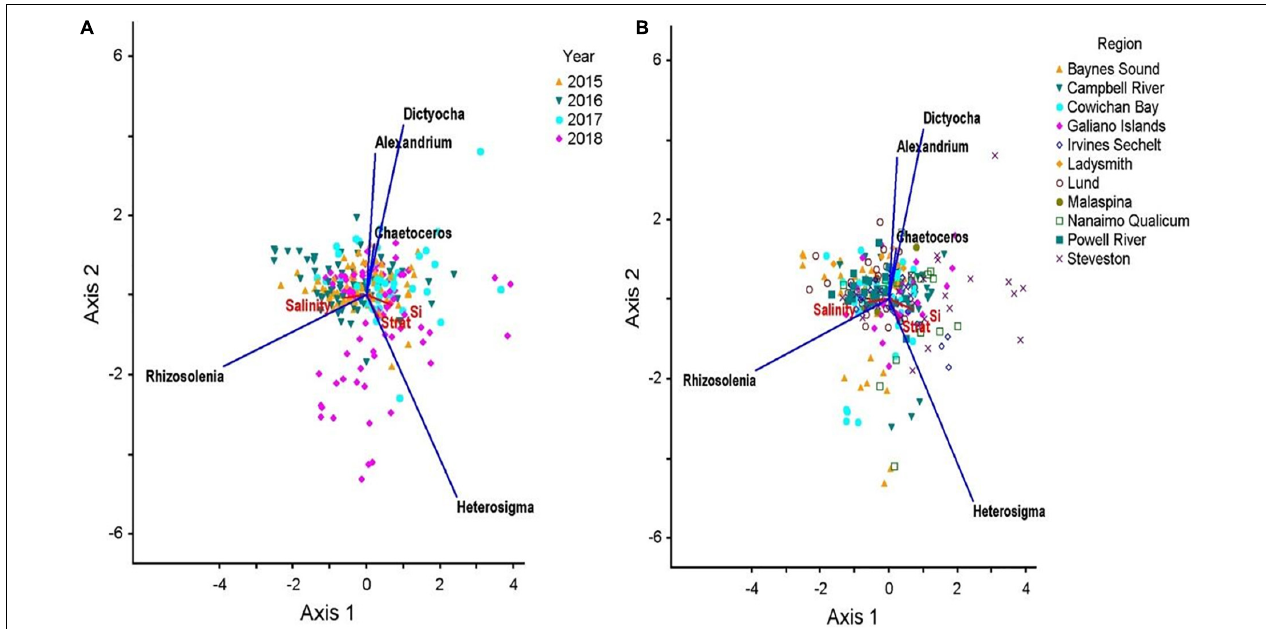
FIGURE 8 | RDA triplots showing the relationships between HABs taxa and physico-chemical parameters averaged across all summers from 2015 to 2017 in the Strait of Georgia grouped by station (A) and year (B) . RDA plots display 9% (RDA axis 1) and 3% (RDA axis 2) of HABs abundance variance. Eigenvalues are 0.045 and 0.016 for the first and second axes, respectively. Vectors show the relationships between physico-chemical variables and the two ordination axes. Vectors pointing in the same direction indicate variables that are highly correlated, whereas vectors pointing in opposing directions indicate the variables are negatively correlated. (Note: only the axes with the two highest variances are